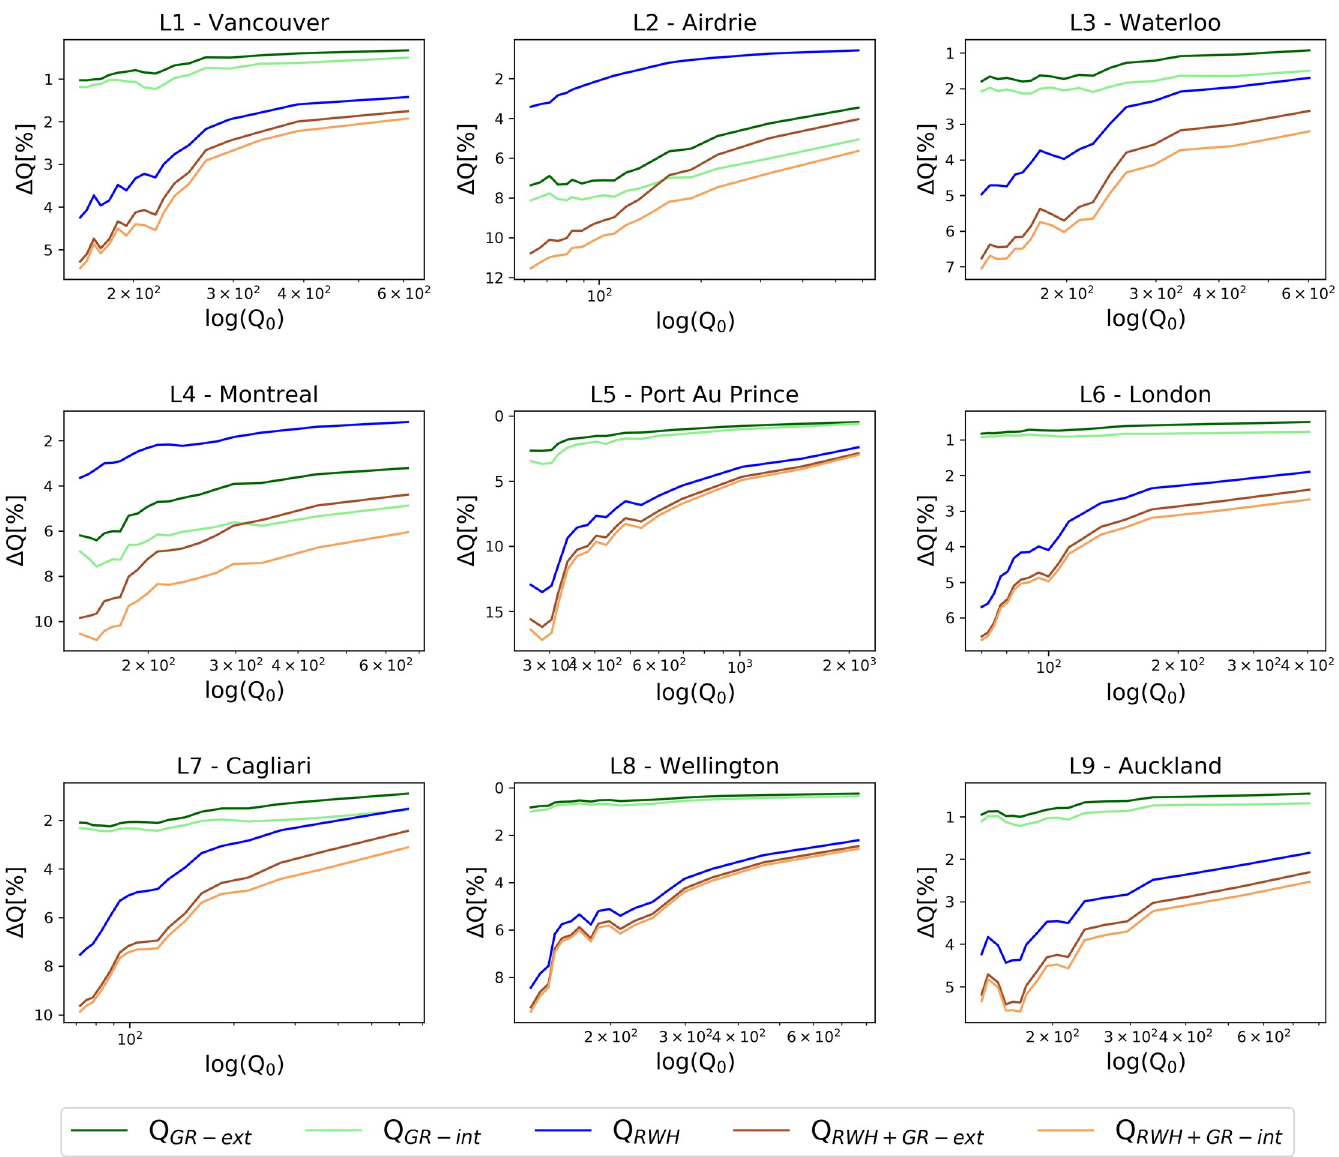
Fig 4. Outflow reduction Δ Q at daily scale as a function of the discharge in unaltered conditions. Moving average outflow reduction Δ Q at daily scale is plotted as a function of the discharge in unaltered conditions at logarithmic scale, for different scenarios in the selected 9 locations. Only events with discharge in unaltered conditions above the 95% quantile are